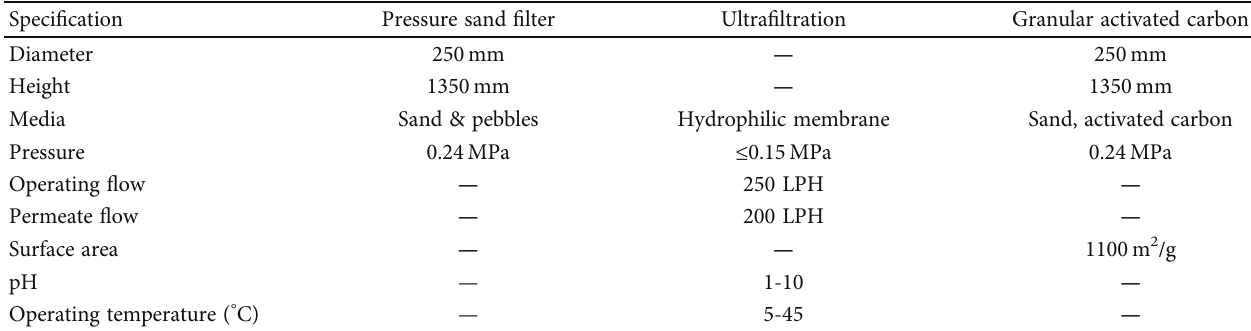
Table 1: Design quality parameters of the advanced treatment